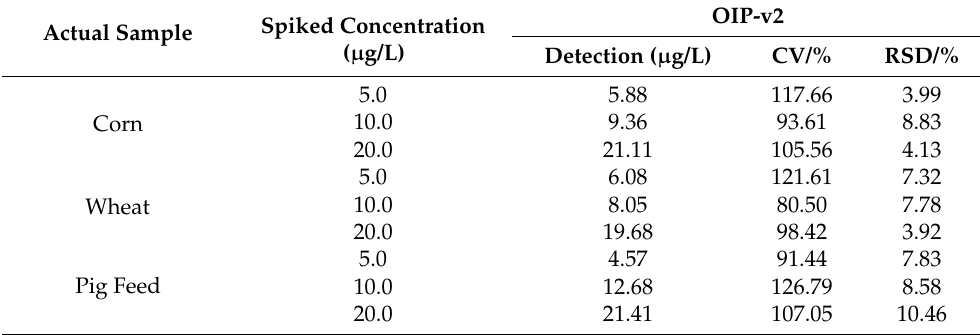
Figure 5. Dose-response curves for the detection of DON ranging from 0 to 10,000 µ g/L at methanol concentrations of 0, 5%, 10%, and 20%. The error bars correspond to the standard deviation of the data points in each of the three repeated experiments ( n = 3). Table 1. Spiked recovery of DON in the real samples (three replicates for each